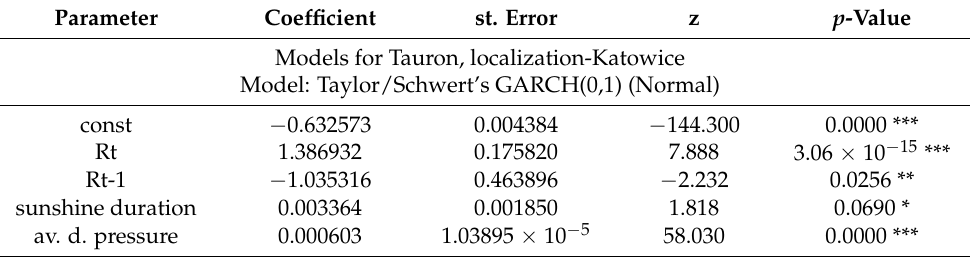
Table 1. Cont. Parameter Coefficient